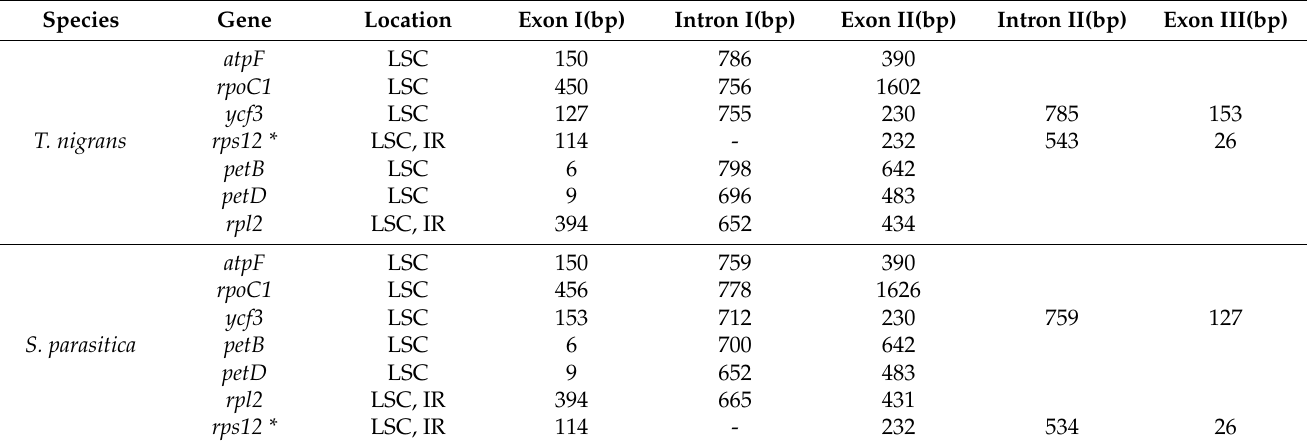
Table 5. Genes with introns in the T. nigrans and S. parasitica chloroplast genomes, including the exon and intron